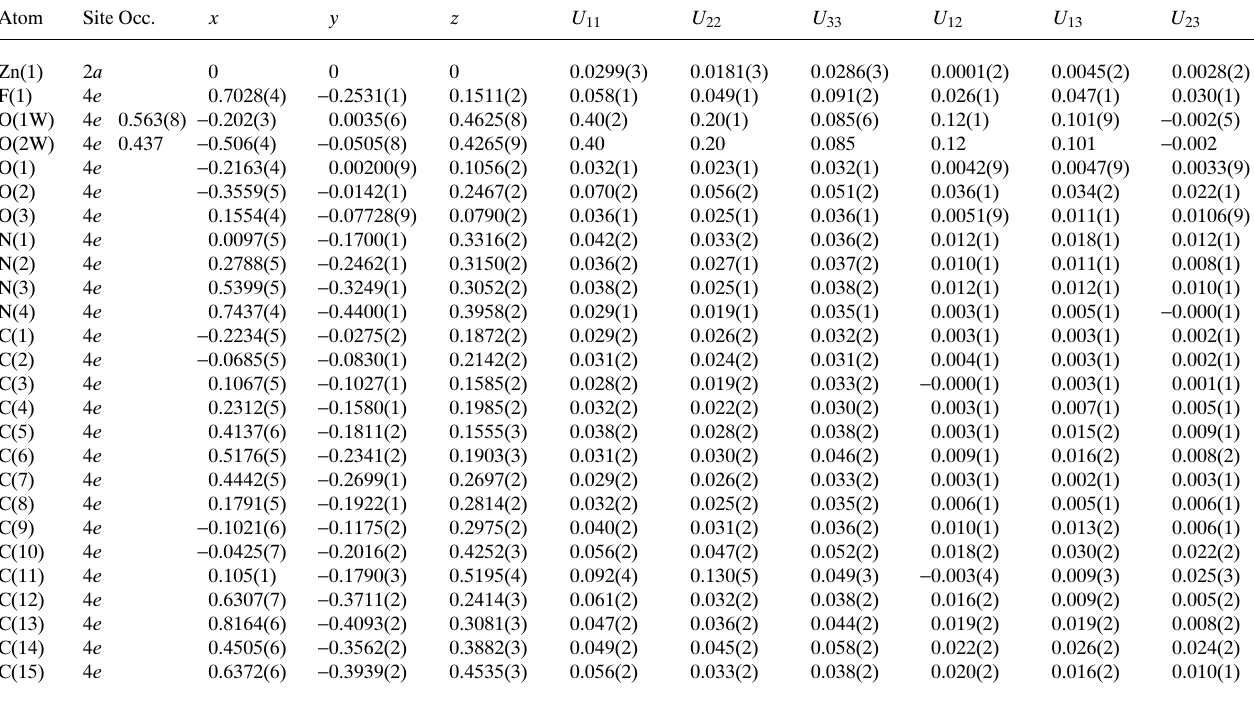
Table 3. Atomic coordinates and displacement parameters (in Å 2 ) .